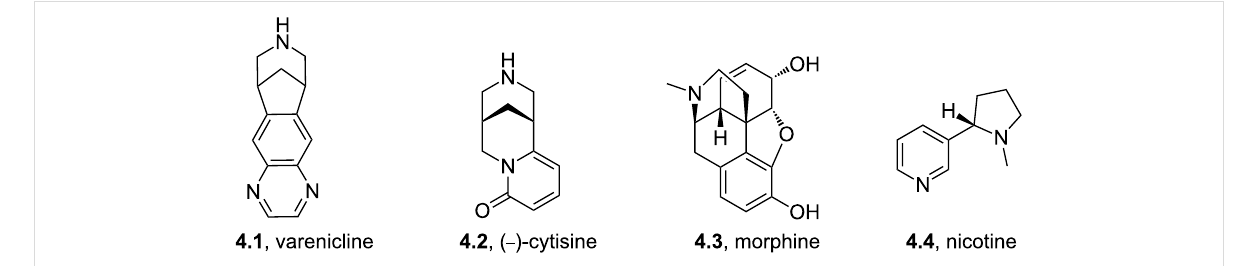
Figure 11: Structure comparison between nicotinic acetylcholine receptor